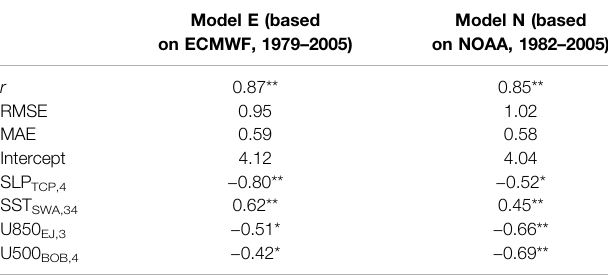
TABLE 2 | Correlation coef fi cients, RMSEs, MAEs, intercepts, and regression coef fi cients of the Model E and Model N. Model E (based Model N (based on ECMWF, 1979 – 2005) on NOAA, 1982 – 2005)